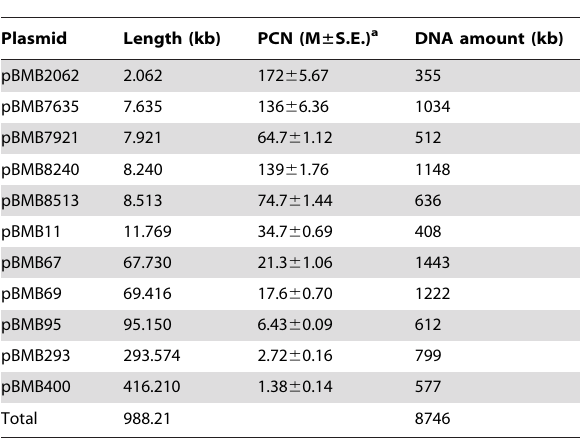
Table 1. PCN of 11 plasmids in strain YBT-1520 determined by real-time qPCR analysis after bacteria grew to the mid- exponential growth stage.